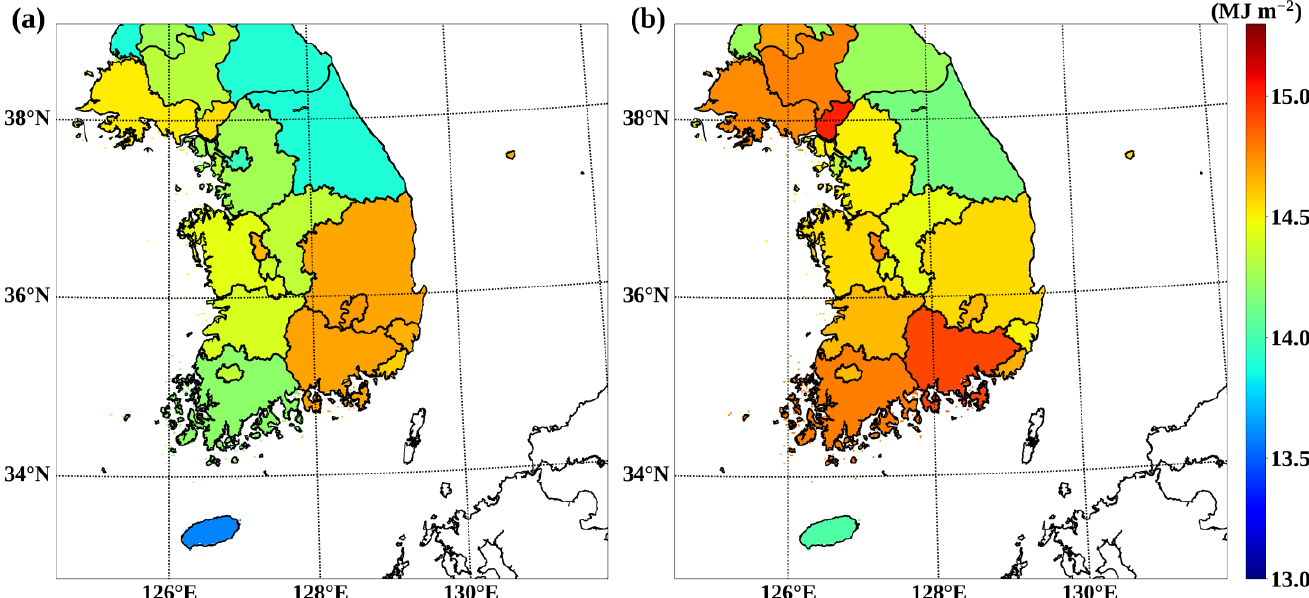
Figure 13. The distribution of annual mean daily SSI, from 1 January 2020 to 31 December 2021, estimated from GK2A/AMI using the CNN approach with respect to administrative districts around Korea in ( a ) 2020 and ( b ) 2021.